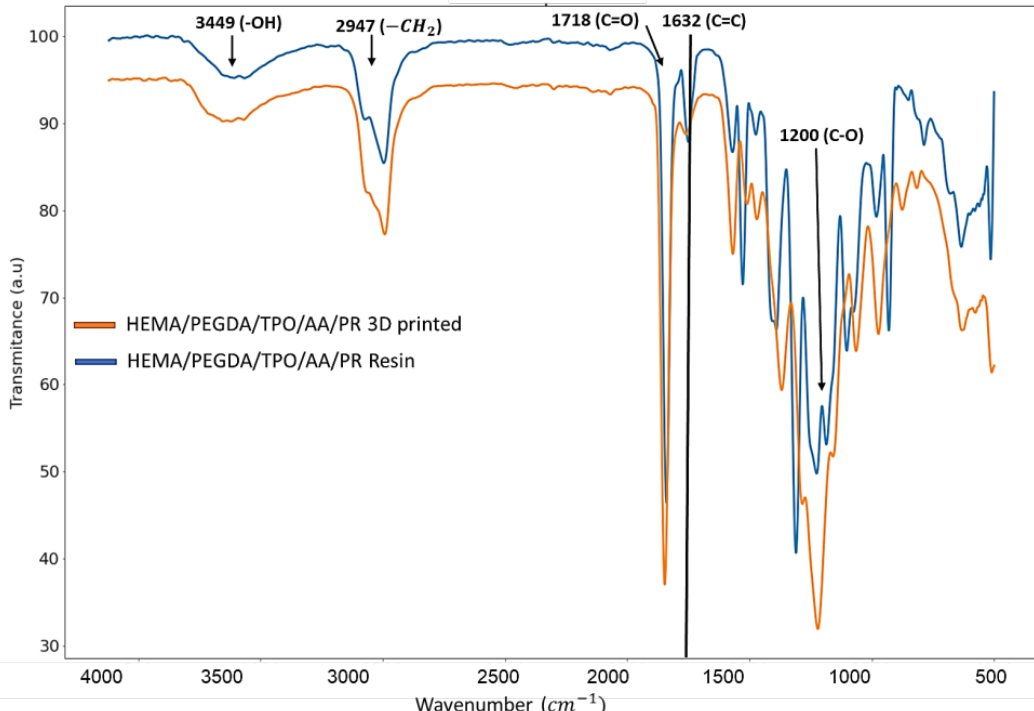
Figure 2. FTIR charctaerzation of HEMA/PEGDA/TPO/AA/PR resin and 3D printed sample. The almost identical trends at all pH levels are likely due to the effect of the pH of HEMA/PEGDA/TPO/AA. HEMA/PEGDA/TPO/AA itself has a pKa ≈ 5.2. In the dry state, the interaction between the dye and HEMA/PEGDA/TPO/AA is weak, so the dye